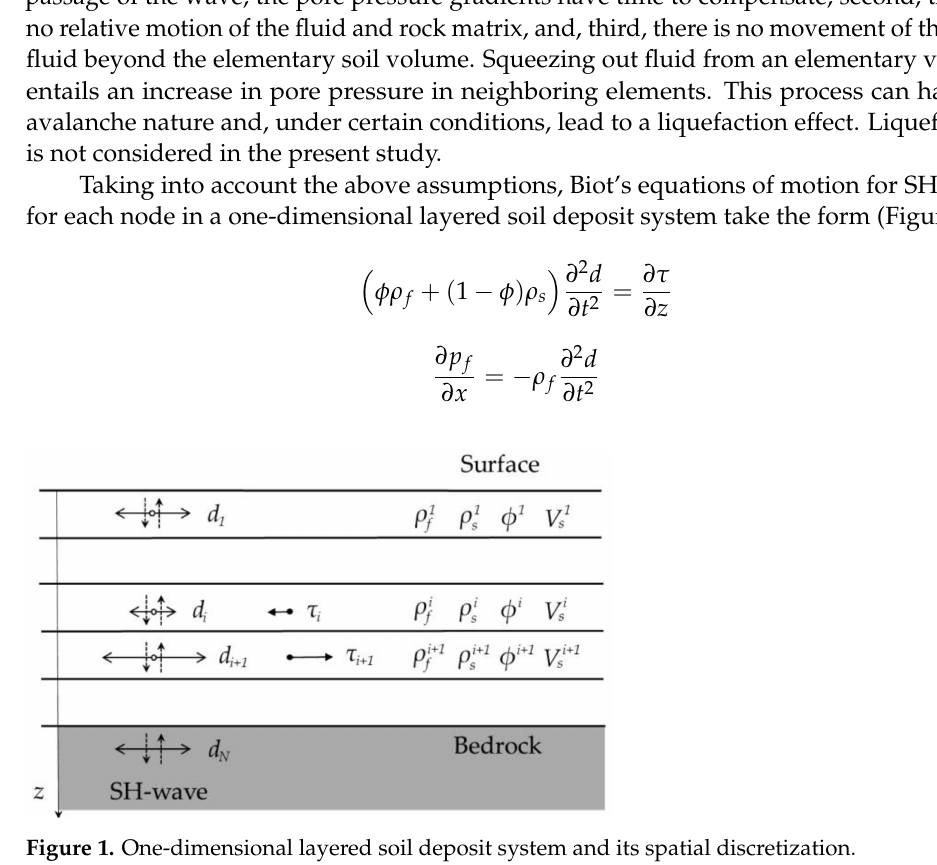
where µ is a mass-proportional damping